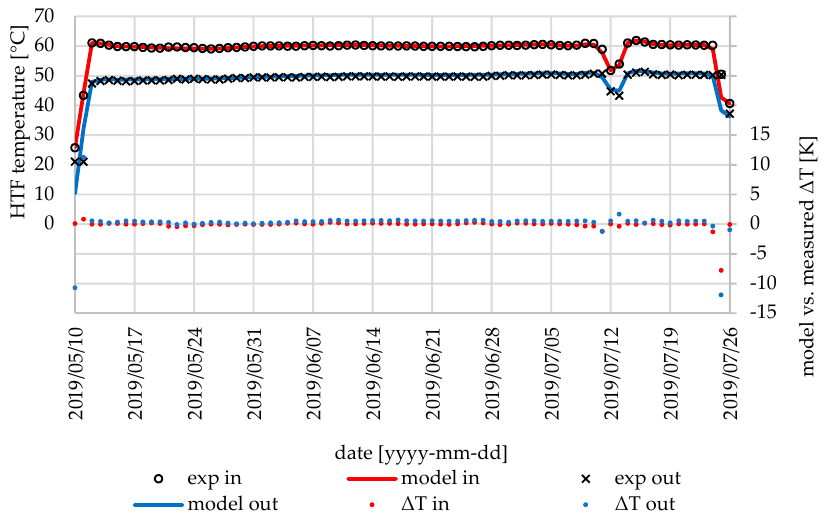
Figure 24. Comparison of model data and measurements for experimental borehole inlet and outlet temperatures.